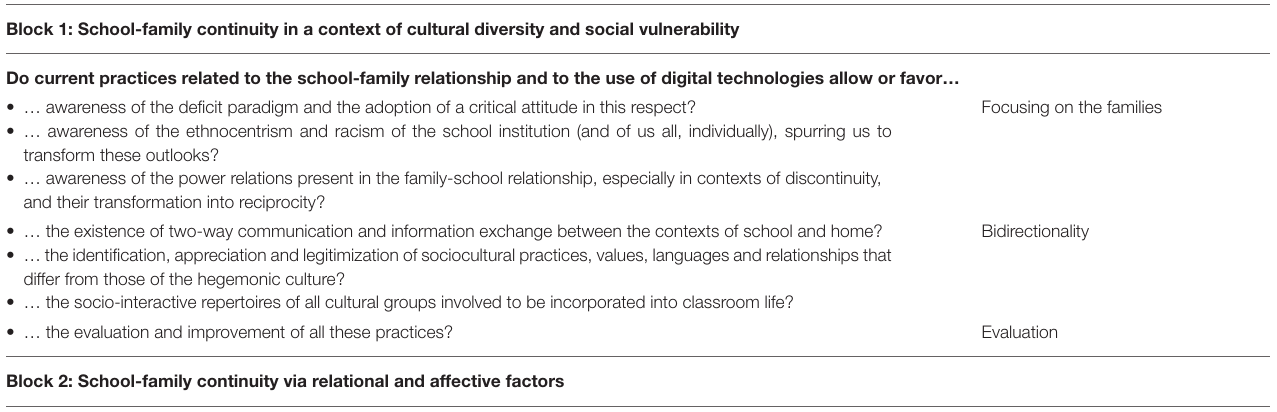
TABLE 1 | Data categorization. Thematic blocks and theoretical questions